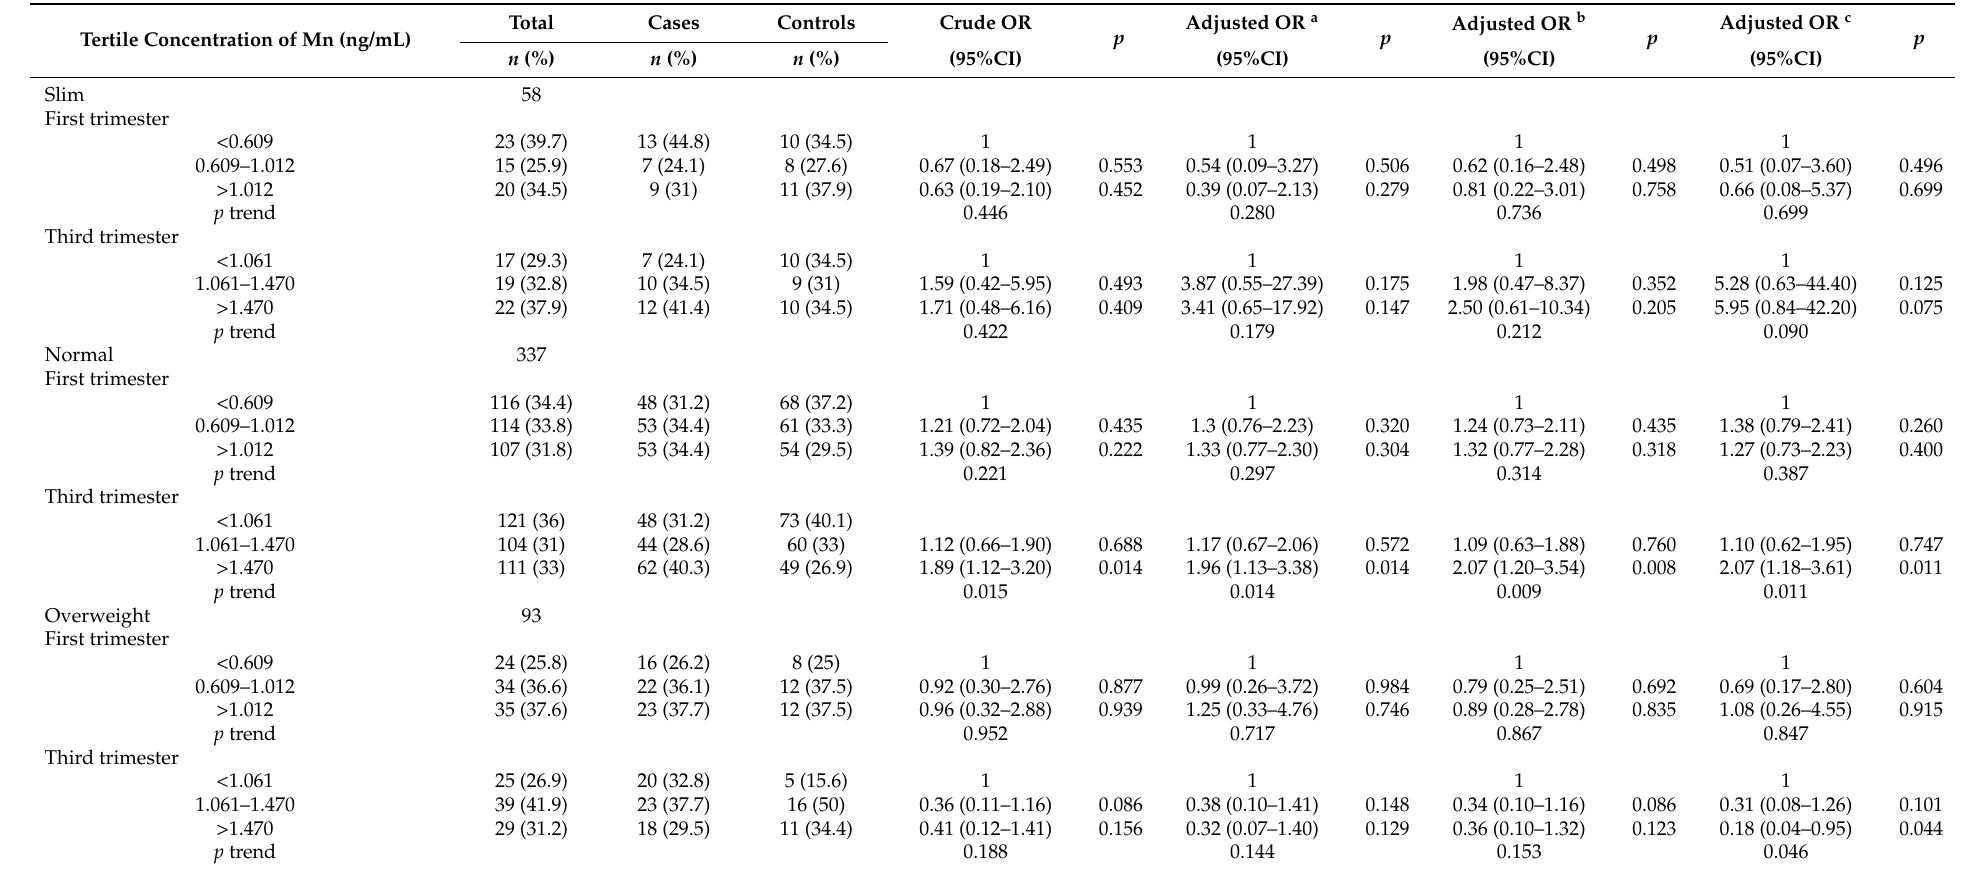
Table 5. Association of maternal plasma Mn levels with SPB stratified by BMI